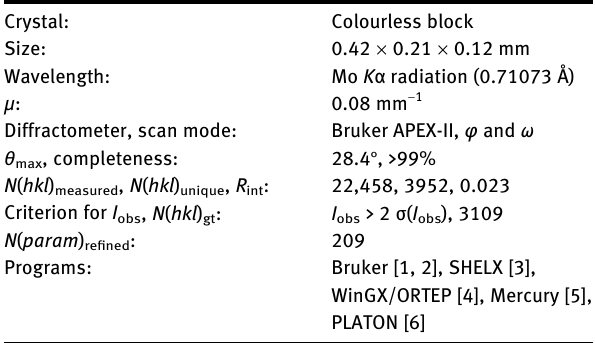
Table  : Data collection and